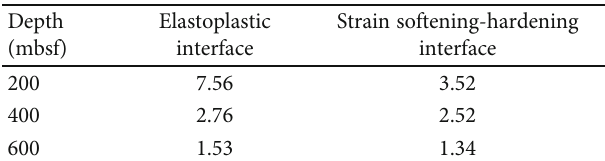
Table 3: Elastic-plastic interface and strain softening-hardening interface r / a corresponding to di ff erent depths.